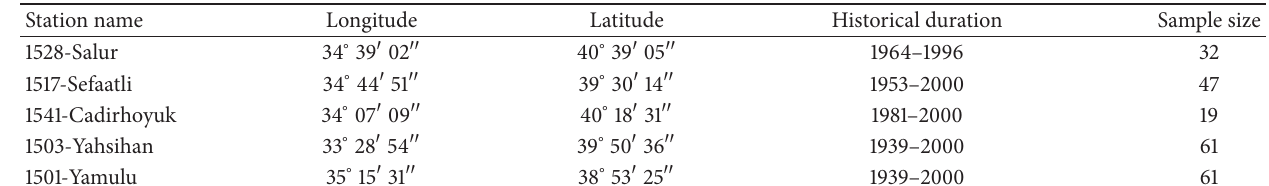
Table 1: Location and characteristic of stations.